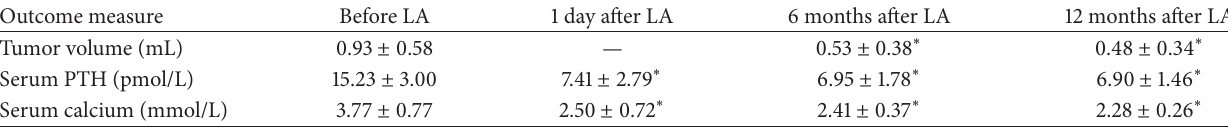
Table 2: Tumor volumes, serum parathyroid hormone levels, and serum calcium concentrations before and after laser ablation therapy. Outcome